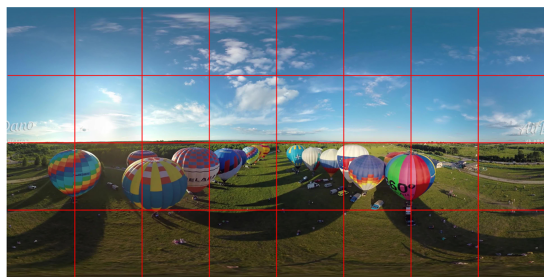
Figure 2. An ERP VR video frame with 4 × 8 tiles.